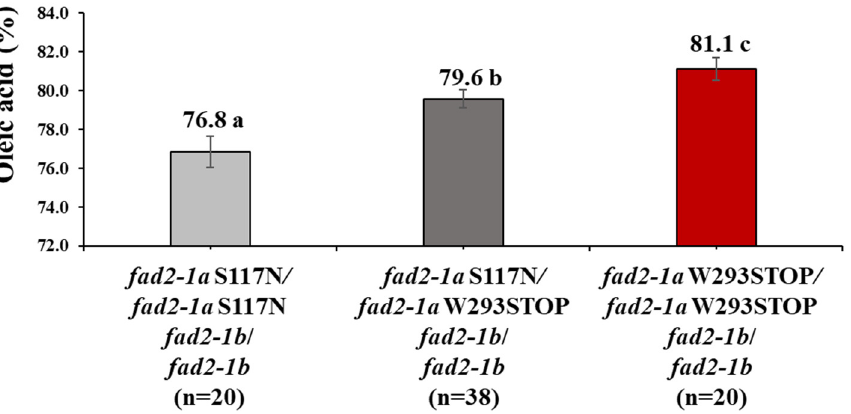
Figure 3. Distribution of oleic acid concentrations from a cross of PE529 and PI 283327 and fatty acid profiles by gas chromatography. A total of 235 F 2 seeds of the population showed altered oleic acid portion based on its genotype of FAD2-1A and FAD2-1B gene. The FAD2-1A and FAD2-1B indicates functional microsomal delta-12 fatty acid desaturase 2 gene which is similar to the Williams 82 reference sequence for Glyma.10G278000 and Glyma.20G111000 , respectively. The fad2-1a indicates mutant allele of FAD2-1A W293STOP in PE529. The fad2-1b represents variant in FAD2-1B gene in PI 283327 (P137R). The PE529 has a mutant allele of FAD2-1A gene ( fad2-1a W293STOP) and a functional allele of FAD2-1B gene. PI 283327 contains a homozygous functional FAD2-1A gene and a fad2-1b P137R allele. The letters above the bars are statistically different based on least square difference.